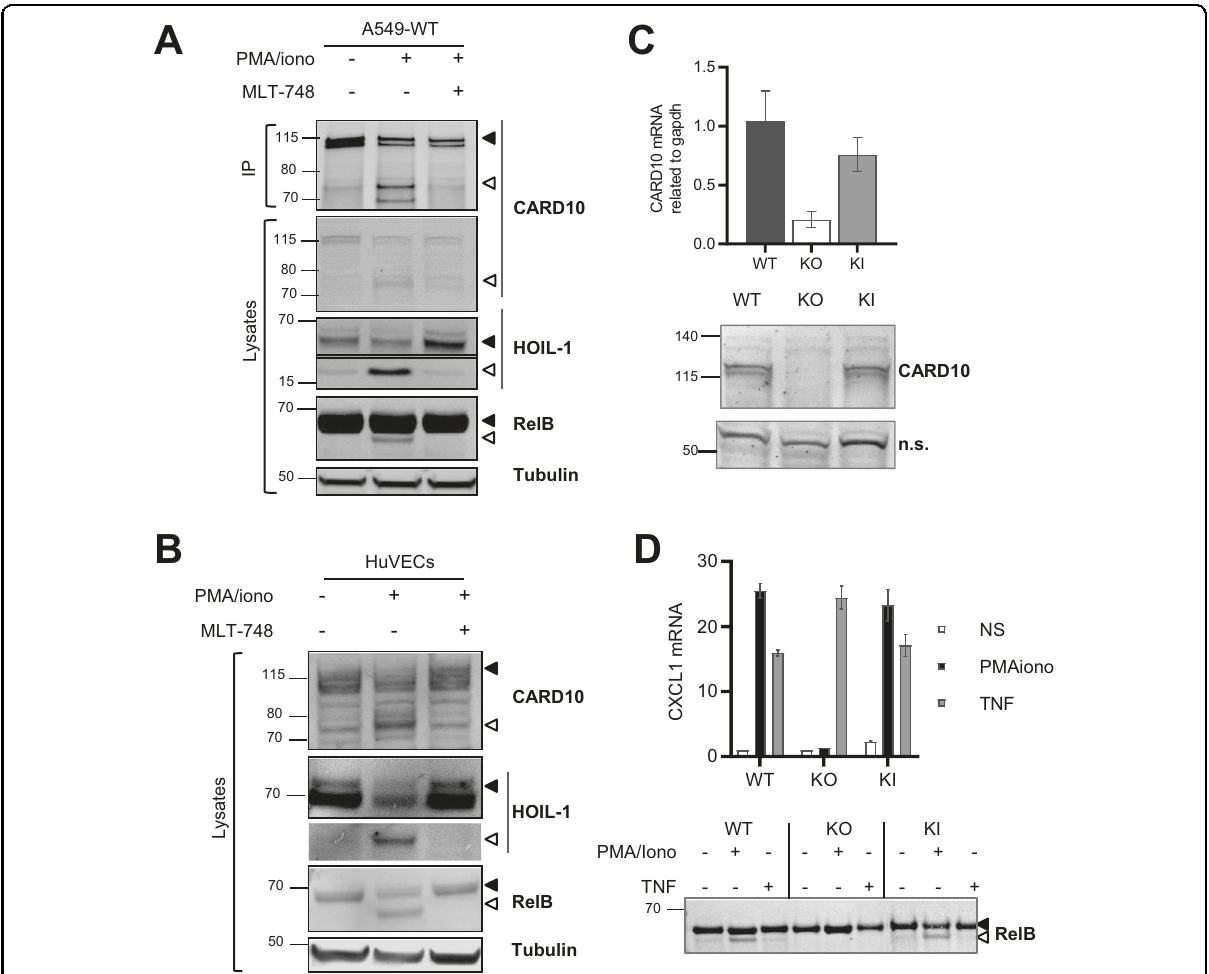
Fig. 2 Endogenous CARD10 cleavage in A549 cells and primary HuVEC cells. A A549 cells were treated with 5 µM of the proteasome inhibitor MG-132 and stimulated for 2 h with P/I ± 1 µM of MLT-748. CARD10 immunoprecipitation was performed and CARD10 expression assessed by Western blotting together with the two MALT1 substrates HOIL1 and RelB ( N = 3). B HuVECs were treated and analyzed as done in ( A ) for A549 ( N = 2). C CARD10 mRNA levels obtained from microarray analysis with probe 210027 (top panel). CARD10 immunoblot performed on full lysates obtained from A549-WT, -KO, and -KI cells (bottom panel). D A549-WT and KI cell lines were treated for 2 h with P/I (50 µg/ml /1 μ M) or TNF (10 ng/ ml) as non-CBM activation control in presence of 5 μ M of MG-132. Relative quantitative PCR measurement of CXCL1 mRNA; Mean ± SD of triplicates ( N = 2). RelB cleavage was then assessed by Western blot (bottom